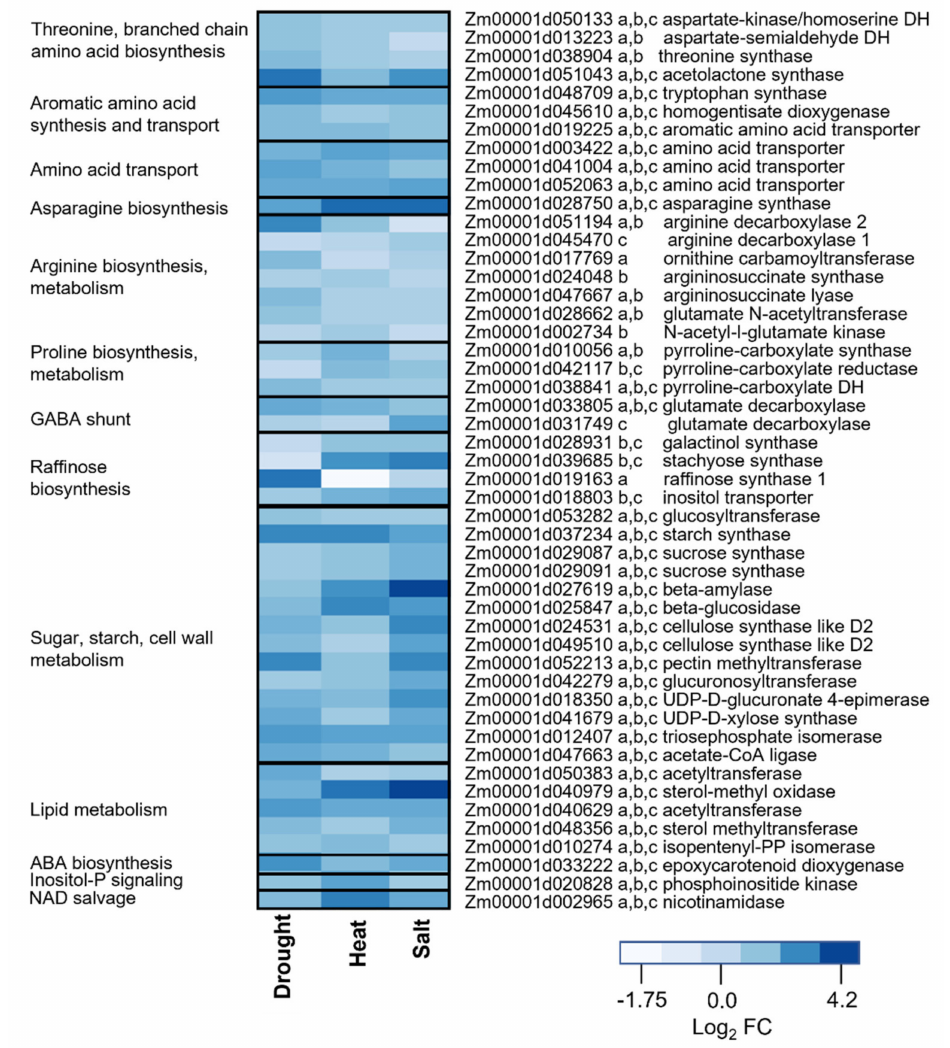
Figure 4. Gene expression changes in metabolic pathways upregulated by long-duration abiotic stresses. The heatmap of log 2 FC values includes 33 genes upregulated in all three stress treatments, plus functionally related amino acid and raffinose pathway genes upregulated in at least one stress treatment. The heatmap was created using the heatmap function in R. Lowercase letters following the gene identifier indicate statistical significance ( p ≤ 0.05) in a, drought; b, heat; and c, salt experiments. DH,